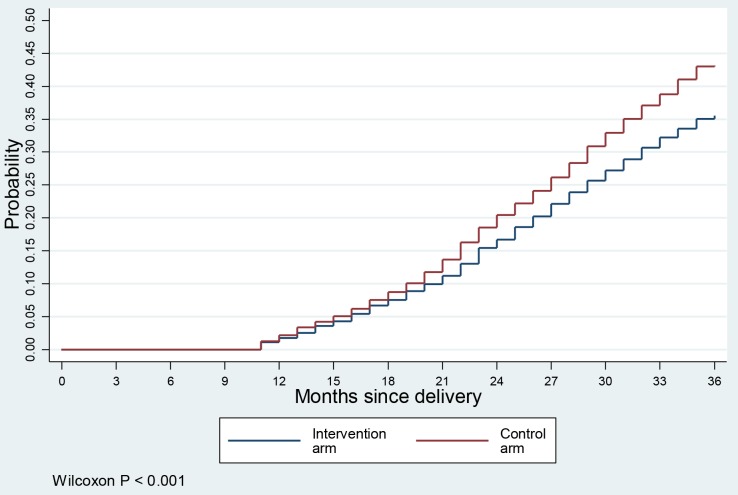
Birth-birth intervals.